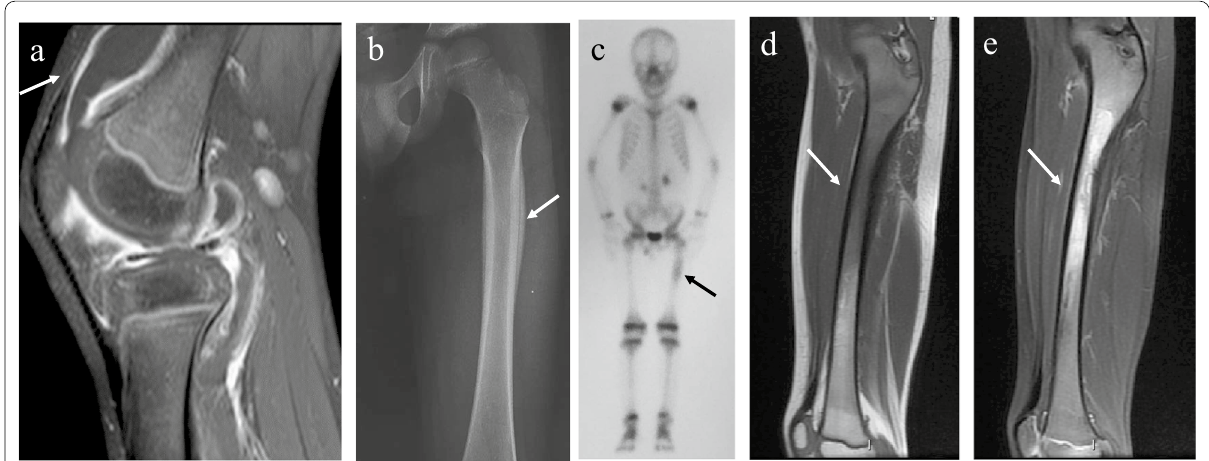
Fig. 2 A 5-year-old boy presented with a swollen and painful right knee. Sagittal fat-saturated T1-weighted image (ceFST1WI) shows synovitis with joint effusion and inflammatory changes in adjacent soft tissues ( a ). After 5 months, he presented pain in his left thigh. Plain radiograph showed a single-layered periosteal reaction on the proximal diaphysis of the left femur ( b ) and bone scintigraphy shows uptake on this site ( c ). Sagittal T1WI ( d ) and fat saturated T2WI (FST2WI) ( e ) show edema and periosteal thickening of the proximal diaphysis of the femur. The diagnosis of chronic nonbacterial osteomyelitis was confirmed with histopathological nonspecific inflammatory changes and negative culture results from two bone biopsies. Synovitis occurs in 5–30% of cases of CNO and single lesions and diaphyseal involvement are rare forms of presentation (“SAPHO-like”)